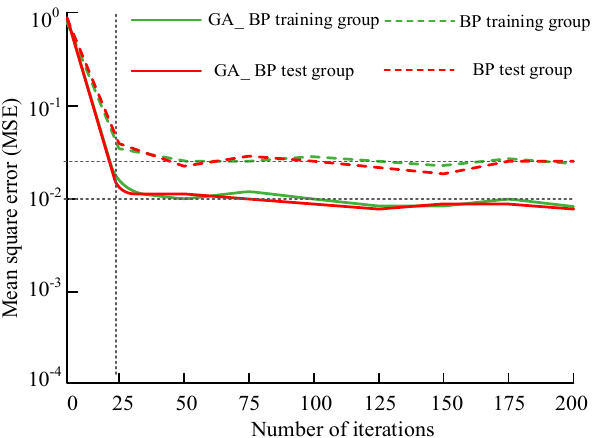
Figure 9. Change of mean square error before and after improvement of the BP neural network.